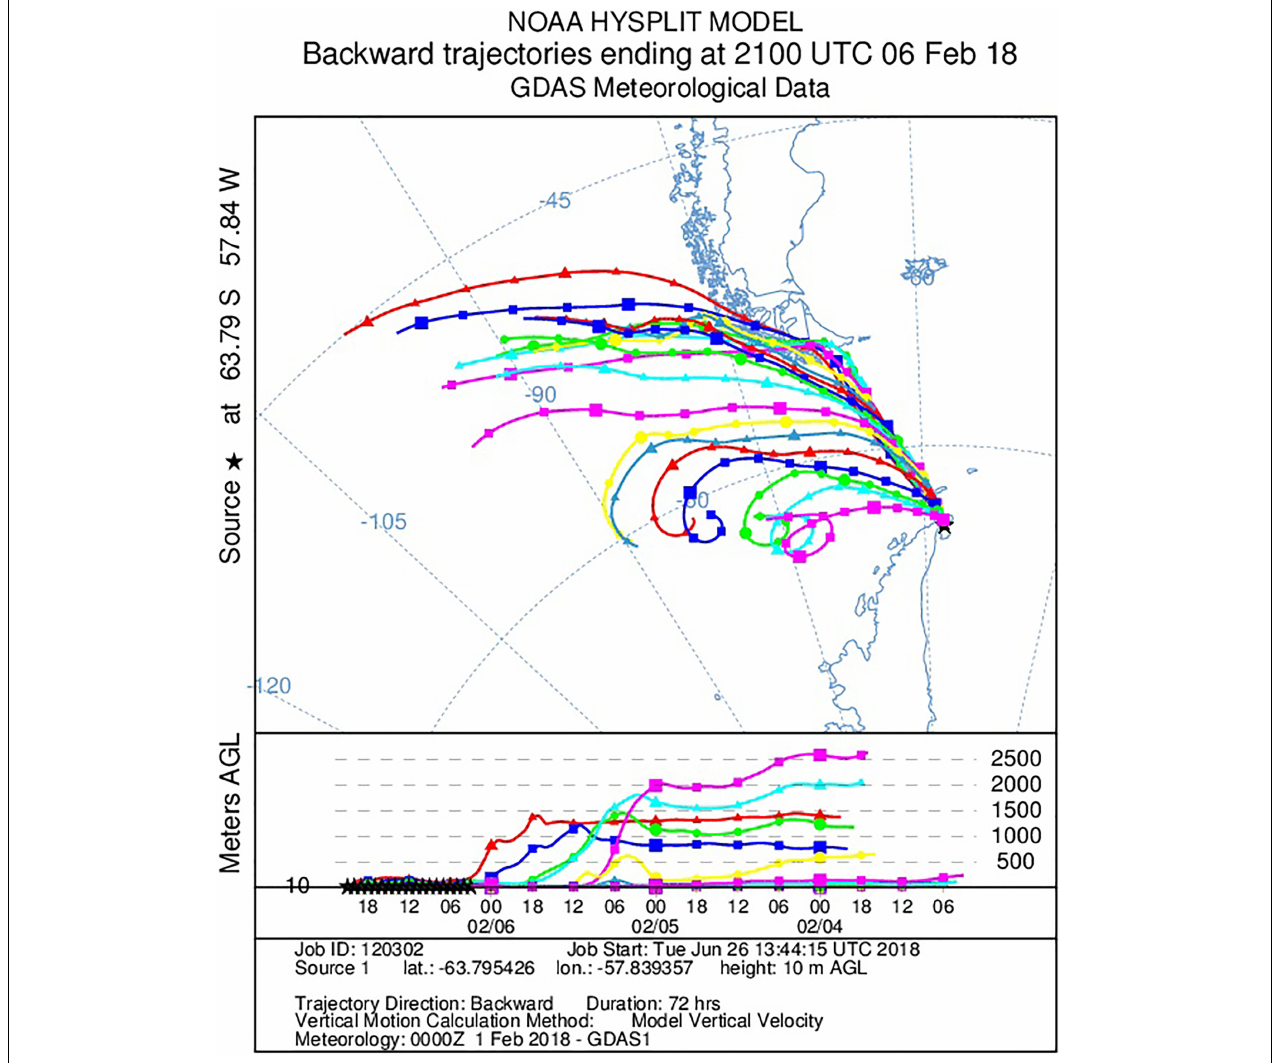
FIGURE 10 | NOAA HYSPLIT model backward trajectories for beginning of February 2018 (ending at 21:00 UTC 6 February, 2018); source: NOAA Air Resources